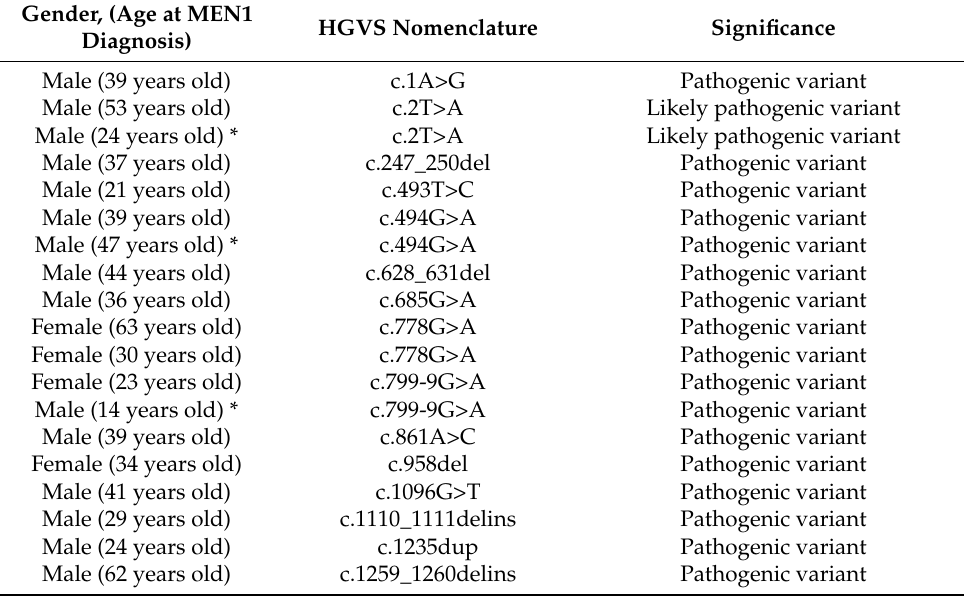
Table 2. Summary of identified variants MEN1